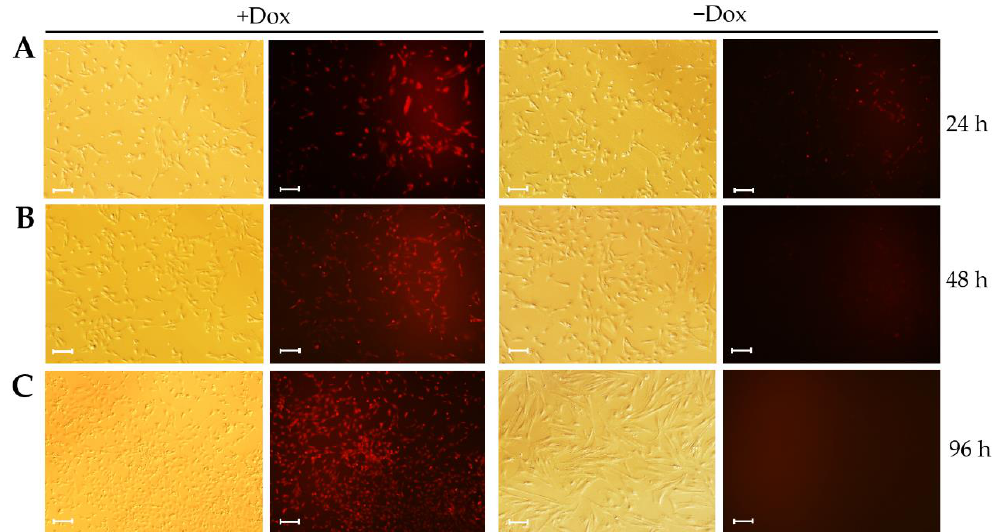
Figure 3. Dox inducible expression of Large T and mCherry. The mCherry expression was observed in CIPGCs with or without Dox at 24 h ( A ), 48 h ( B ), and 96 ( C ), respectively. CIPGCs, conditional immortal porcine GCs. The experiment was repeated three times. Bar at 50 µm.